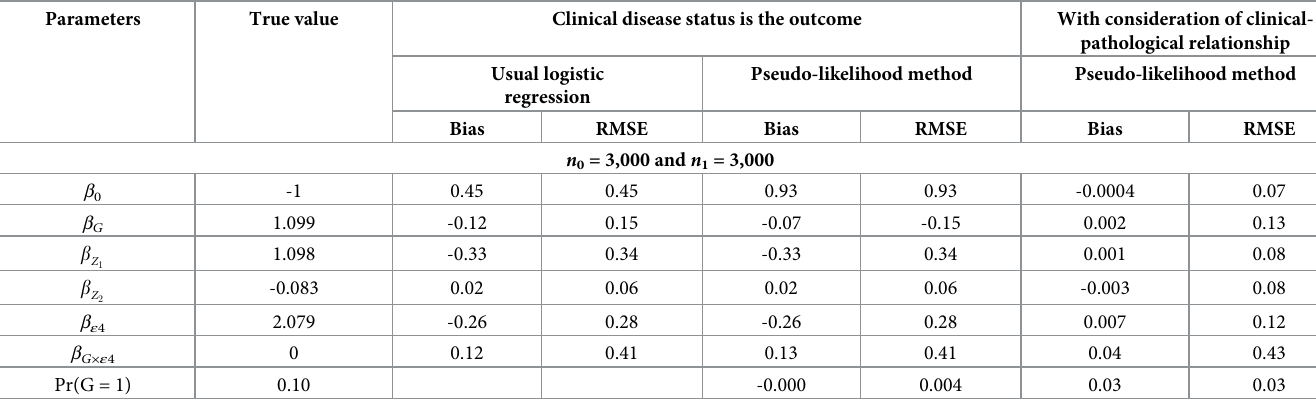
Table 2. Bias and RMSE in parameter estimates when β G × ε 4 =